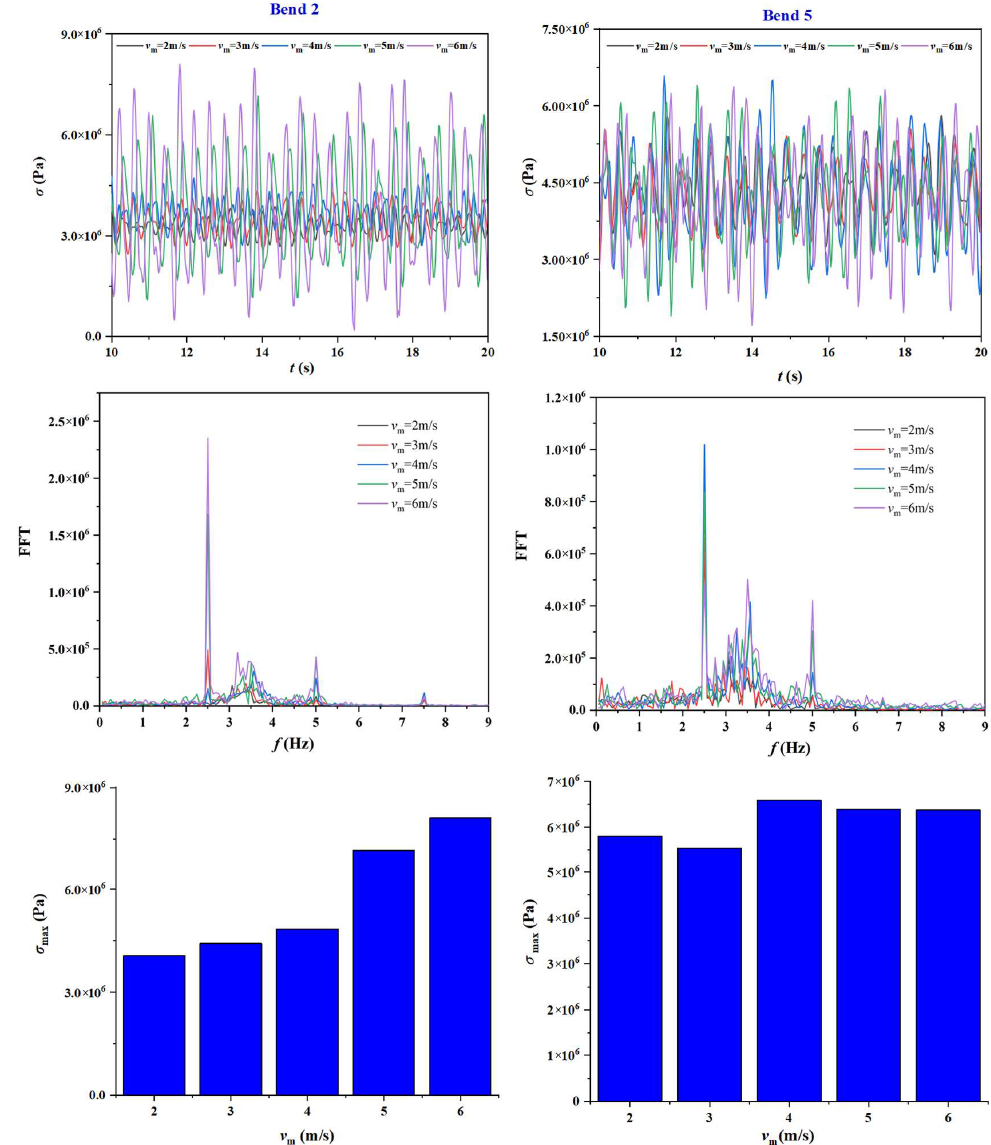
Figure 20. Comparison of the stresses of Bend 2 and Bend 5 at different mixture velocities, where v m is the mixture velocity, σ max is the maximum stress, σ is the structural stress, f is the fluctuation frequency and t is the flow time.